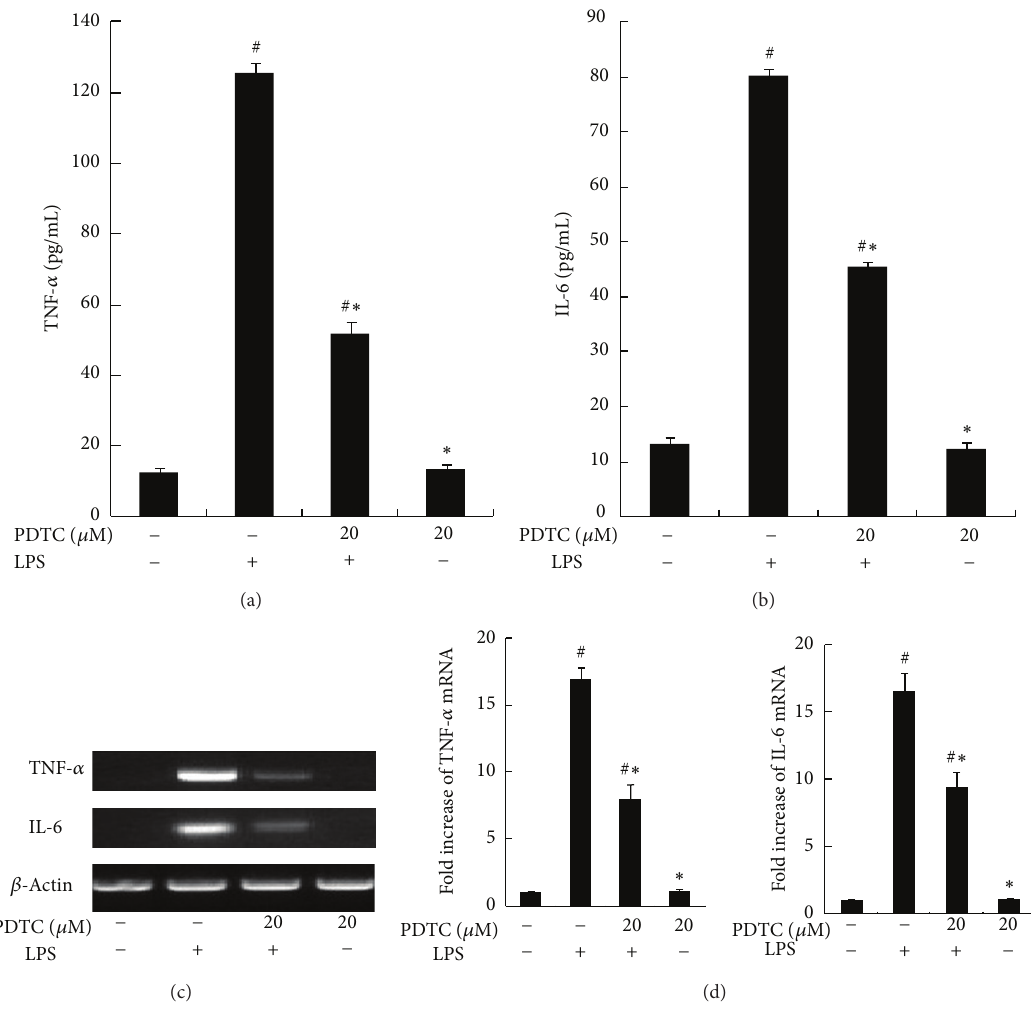
Figure 4: Effect of NF- 𝜅 B Inhibitor on LPS-induced TNF- 𝛼 and IL-6 expression. RAW264.7 macrophages were pretreated with dimethyl sulfoxide (DMSO) or 20 𝜇 M pyrrolidine dithiocarbamate (PDTC) for 1h and stimulated with 100ng/mL LPS for 8h. The concentrations of TNF- 𝛼 and IL-6 in culture supernatants were measured by ELISA. (c) RAW264.7 macrophages were pretreated with dimethyl sulfoxide (DMSO) or 20 𝜇 M PDTC for 1h and then stimulated with LPS for 2 h. Steady state mRNA levels of TNF- 𝛼 and IL-6 were examined by RT- PCR. (d) The levels of TNF- 𝛼 and IL-6 mRNA were quantified by measuring band intensities and shown as fold increase relative to 𝛽 -actin mRNA levels. Each value represents the means ± SD for 𝑛 = 4 . # and ∗ indicate statistically significant differences ( 𝑃 < 0.05 ) between propofol and LPS treated and LPS only treated groups,